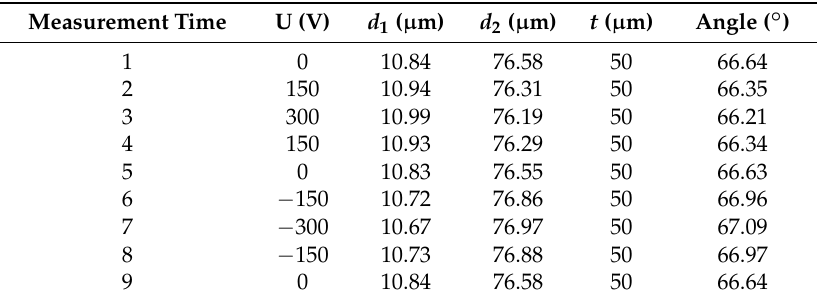
Table 2. Parameters of the micro-tapered aperture at different voltages.